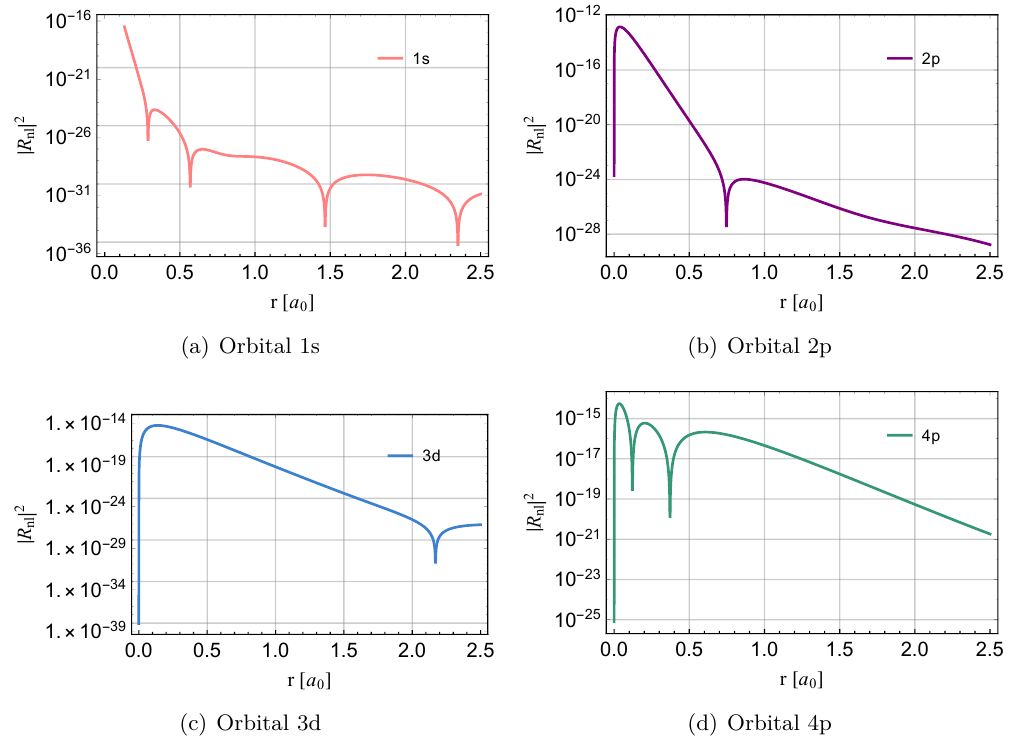
Figure 9 . The radial wave-function R nl ( r ) of the bound electron outside the xenon nucleus. Open